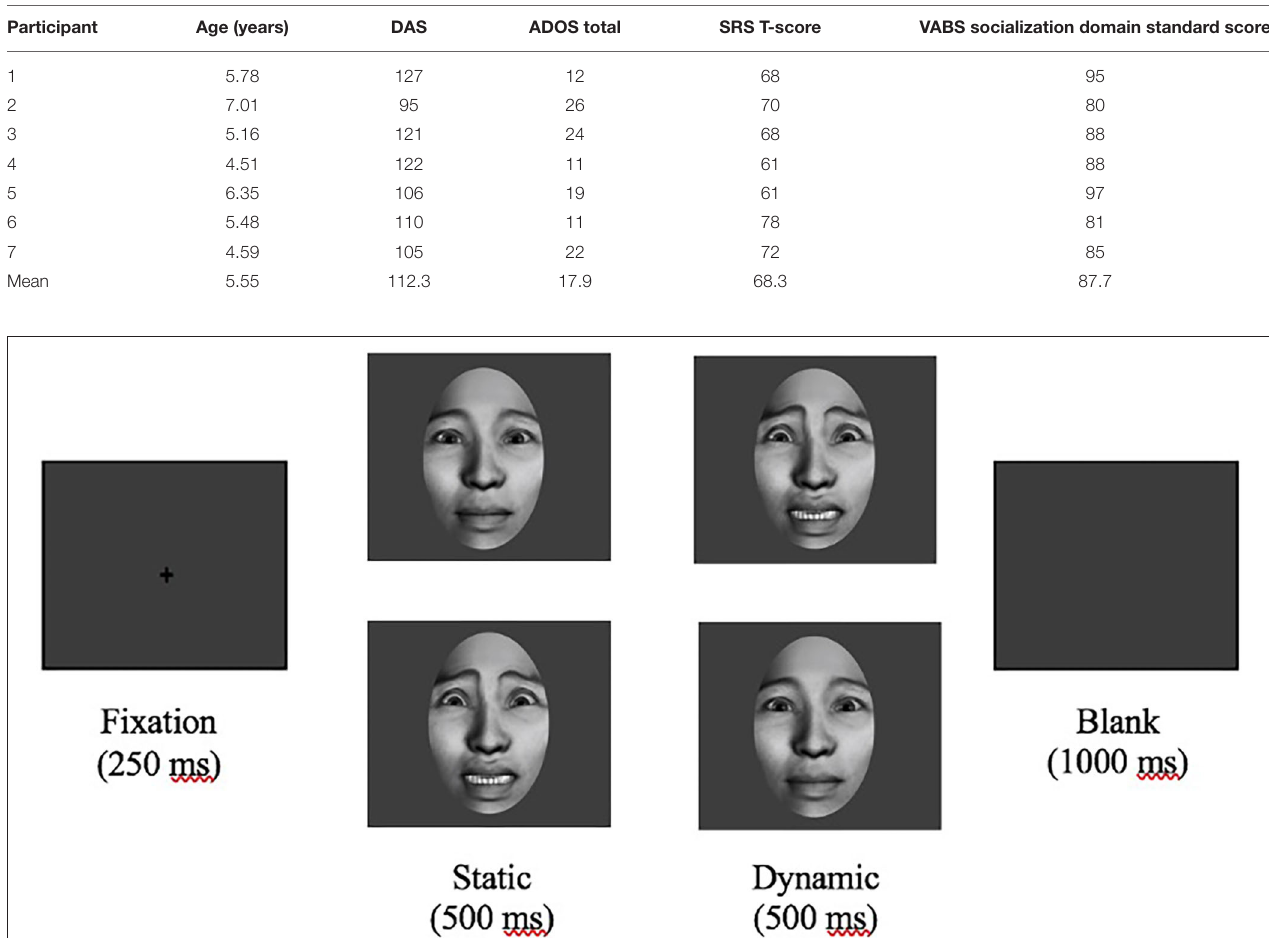
TABLE 1 | Participant information at the pre-PRT timepoint.